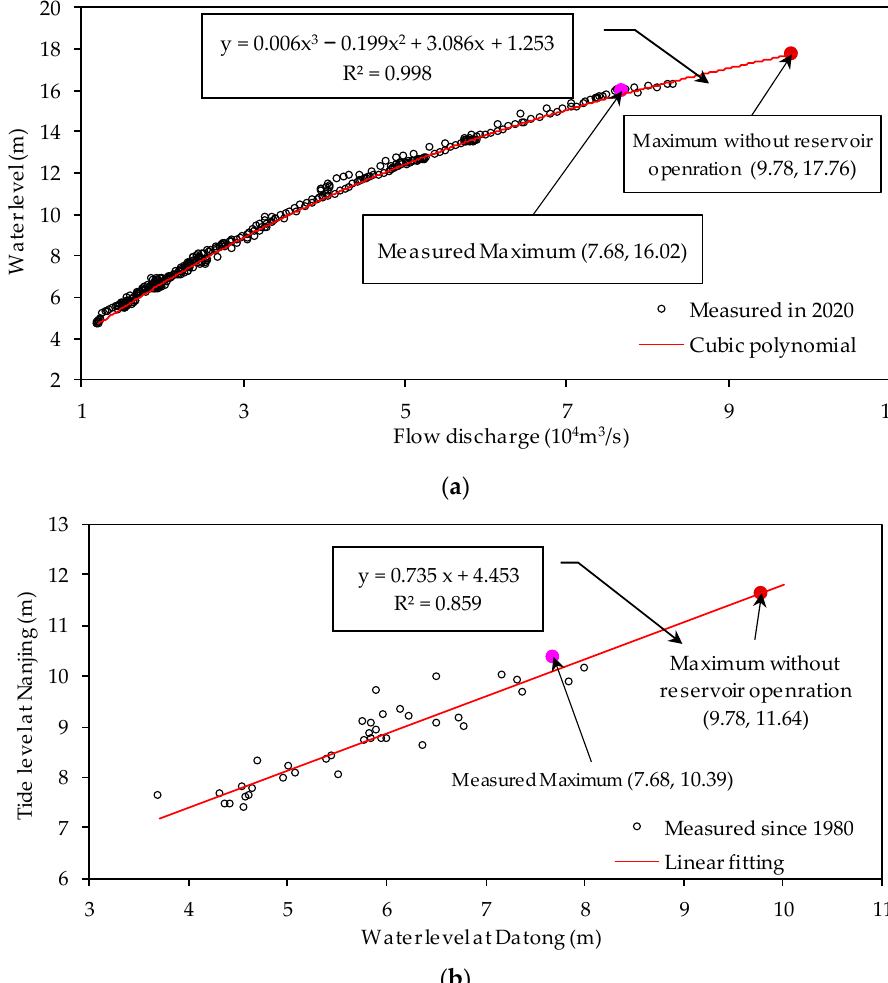
Figure 7. Analysis of maximum flood level without reservoir regulation. ( a ) Relationship between water level and discharge at Datong; ( b ) relationship of highest tide level between Nanjing and Datong.